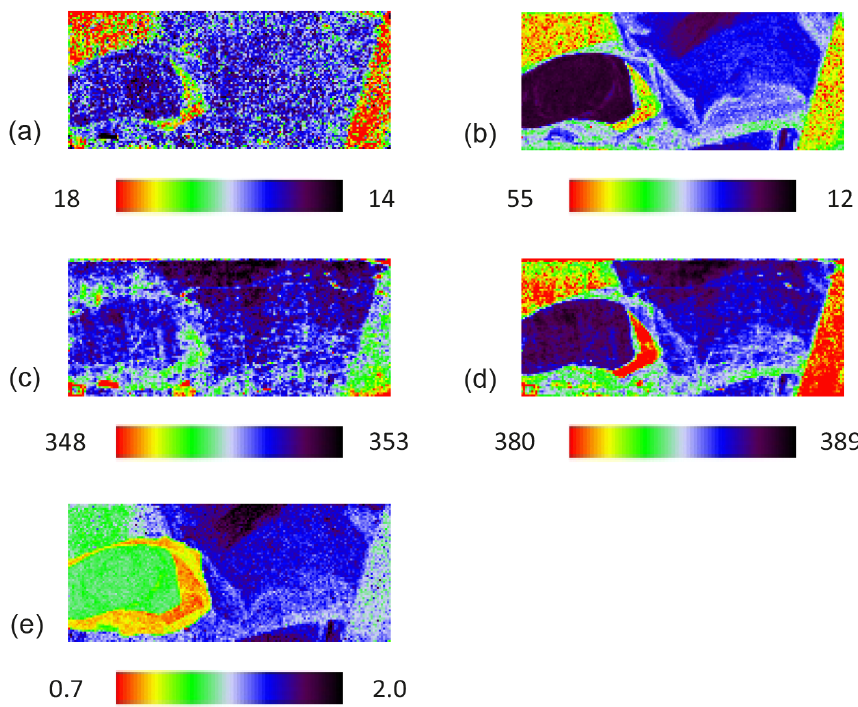
Figure 5. Raman map of pyrite grain with 532nm laser. FWHM of E g (a) and A g (b) modes (presented in cm − 1 ), Raman shift of E g ( c ) and A g (d) modes (presented in cm − 1 ), and intensity ratio of E g and A g (A g / E g ) modes (e) .